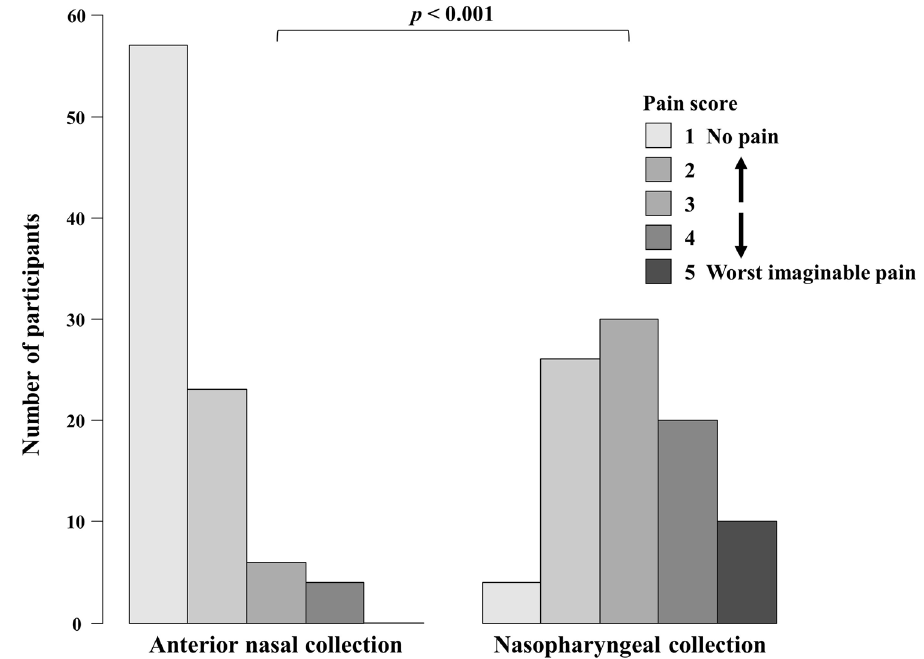
Figure 3. The pain score in anterior nasal collection and nasopharyngeal collection. The severity of pain at swab insertion was assessed on a five-point scale, from 1 to 5 (Pain score). The pain score for each collection method was obtained from the same participant (n = 90). The comparison of the pain scores with the two collection procedures was performed with the Wilcoxon signed-rank